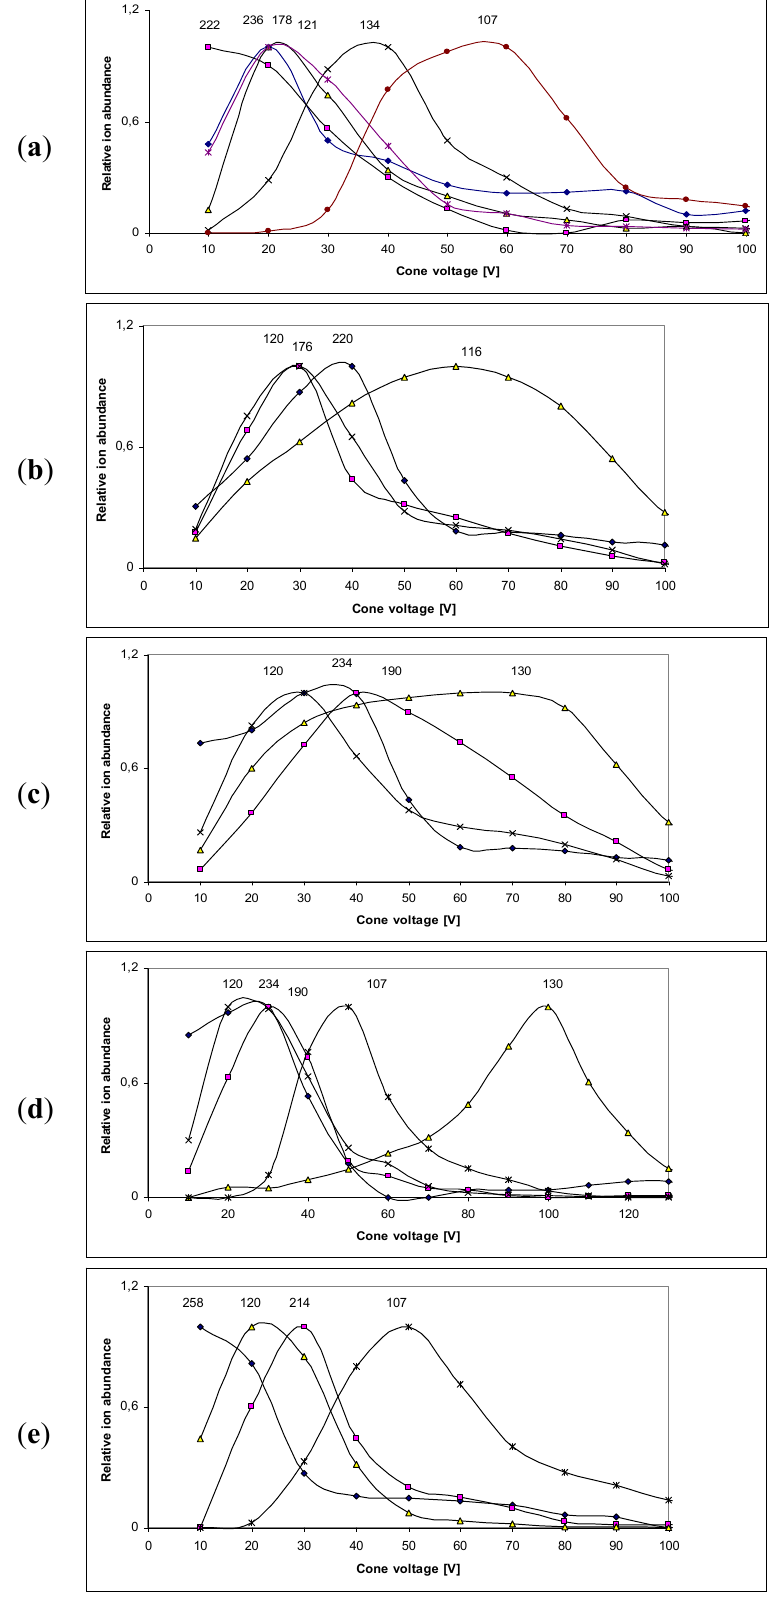
Figure 5. The correlations of relative ion abundance vs. cone voltage for compounds: 1 ( a ); compound 2 ( b ); compound 3 ( c ); compounds 4 ( d ) and compound 5 ( e